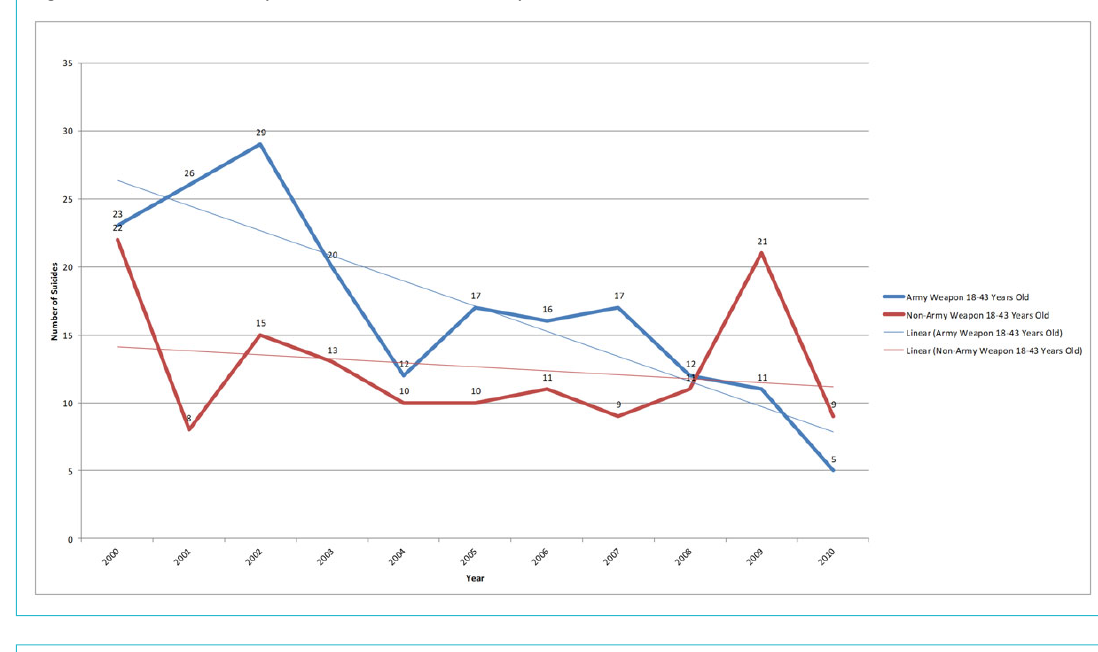
Figure 2: Number of suicides by firearm over time: men 18 to 43 years old.